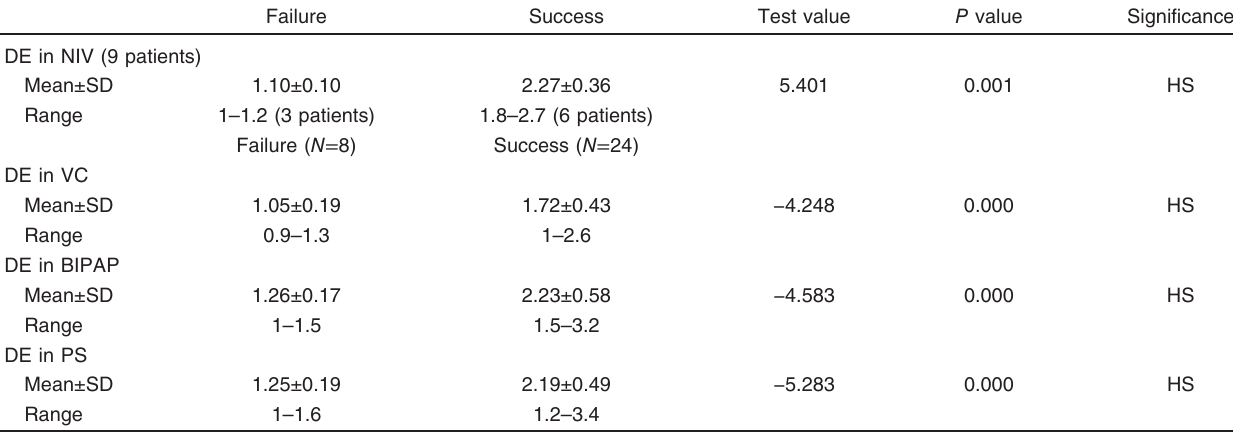
Table 2 Comparison between successful weaning and failed weaning regarding diaphragmatic excursions in each mode of mechanical ventilation (noninvasive, volume control, bilevel positive airway pressure, and pressure support)